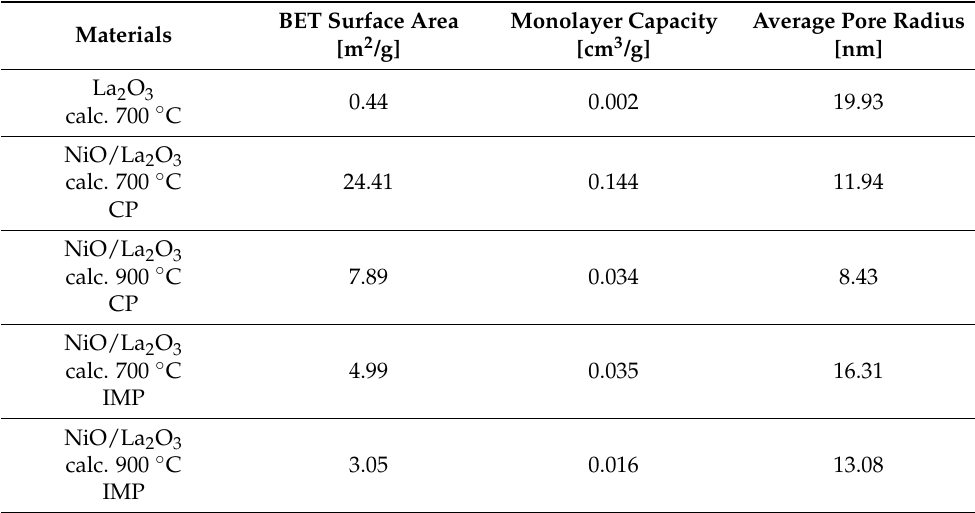
Table 4. The specific surface area, monolayer capacity and average pore size for La 2 O 3 support and NiO/La 2 O 3 catalysts.